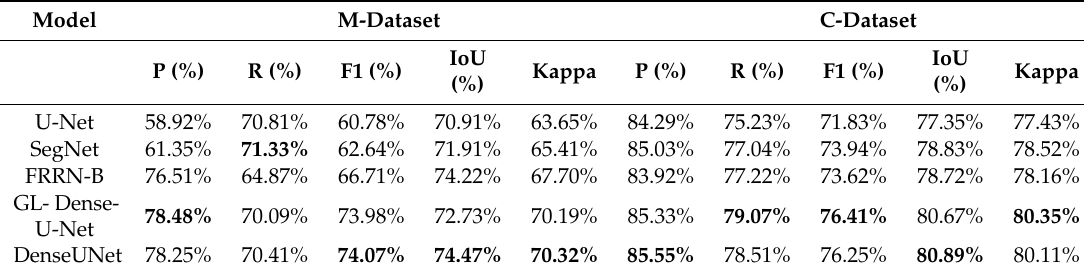
Table 3. The experimental results of road